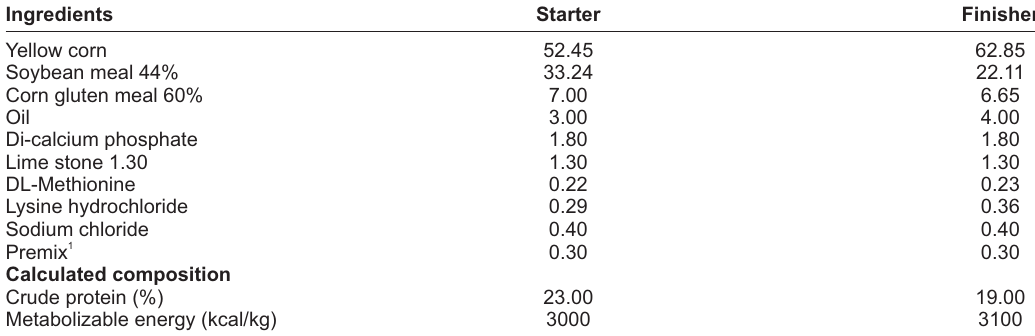
Table-1: Composition of the broilers 3-phase diets (g/kg as fed) and their calculated chemical composition.